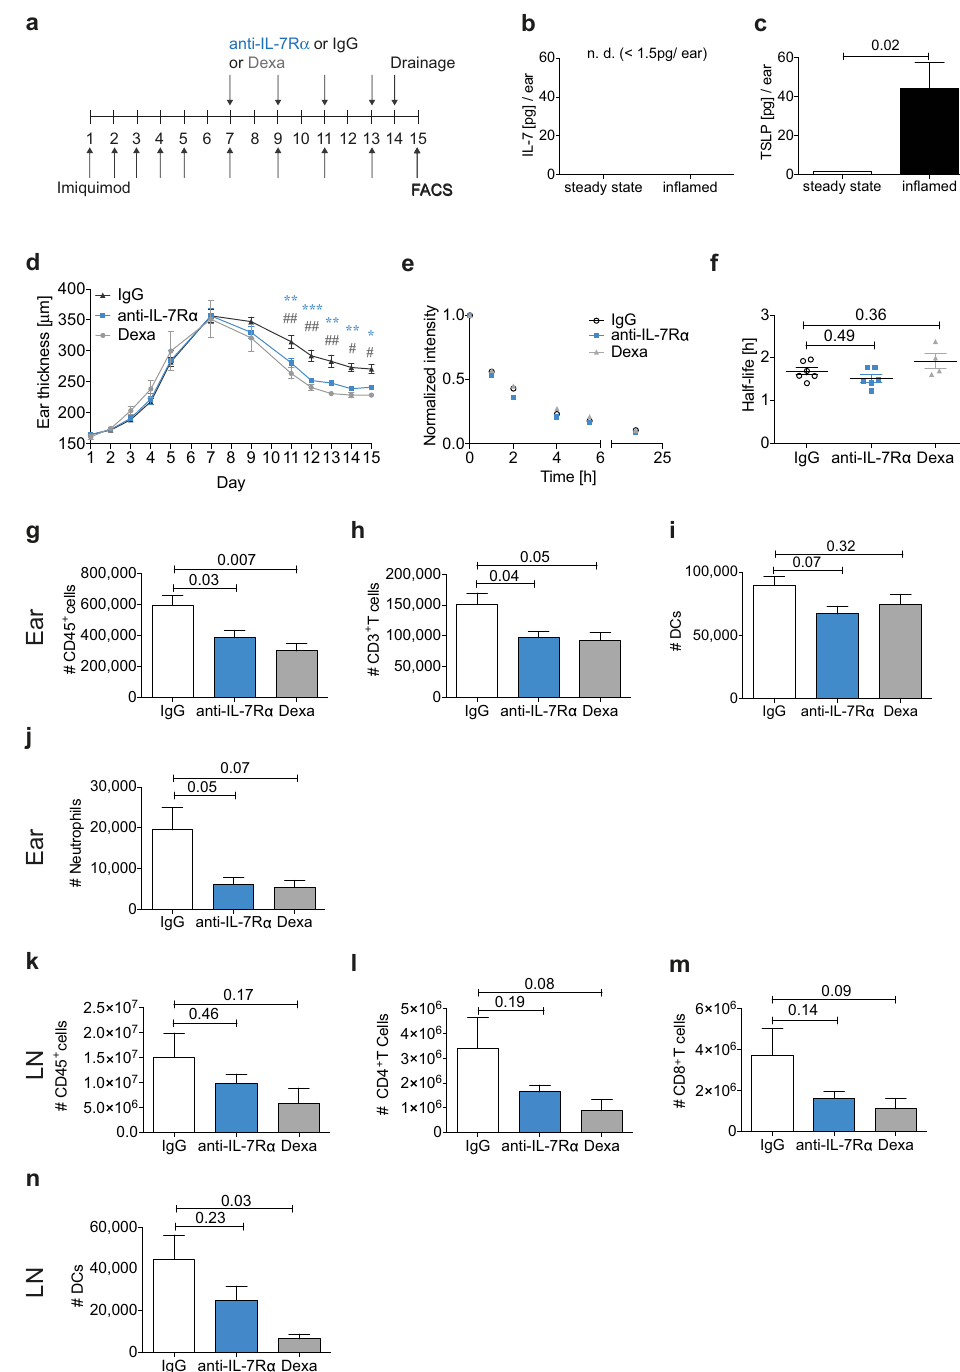
Figure 4. Anti-IL-7R α treatment ameliorates imiquimod-induced inflammation in WT mice. ( a ) Imiquimod- containing cream was applied to the ears on day 1, 2, 3, 4, 5, 7, 9, 11, and 13. Mice were randomized into treatment groups on day 7 and treated i.p. with anti-IL-7R α antibody, corresponding IgG control, or with dexamethasone (Dexa) on days 7, 9, 11, and 13. The ear thickness was measured on each treatment day. Lymphatic drainage was measured on day 14 and the mice were sacrificed on day 15. Immune cell infiltration in the ear skin and dLNs was analyzed by FACS. ( b ) IL-7 and ( c ) TSLP protein levels were measured from ear skin lysates on day 8. ( d ) Ear thickness measurements over the course of the treatment. P values indicated by an asterisk show comparisons between anti-IL-7R α and IgG. P values indicated by a pound sign show comparisons between Dexa and IgG. #/ * p < 0.05; ##/ ** p < 0.01; *** p < 0.001. ( e , f ) Lymphatic drainage analysis: ( e ) Average clearance plots of P20D800 from the ear measured by IVIS and ( f ) the calculated half-lives. FACS-based quantification of the number of ( g , k ) CD45 + cells, ( h ) CD3 + T cells, ( i , n ) DCs, ( j ) neutrophils, ( l ) CD4 + T cells, ( m ) CD8 + T cells measured in the ear skin ( g – j ) and dLNs ( k – n ) on day 15. Both ears and dLNs were pooled for the FACS analysis. Data (mean ± SEM) from 1 experiment with 4–6 mice per group are